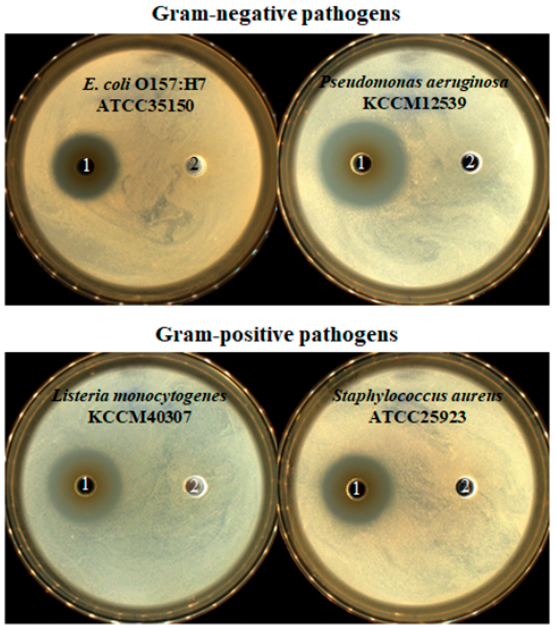
Figure 5. Antibacterial activity of LPLB5. 1, culture supernatant of LPLB5; 2, MRS broth as control. Antibacterial activity of culture supernatant of LPLB5 against E. coli O157:H7, p. aeruginosa, Leu. monocytogenes, S. aureus using the agar well diffusion assay. Four pathogenic bacteria were spread on tryptic soy agar (TSA) plates, then 120 µ L of culture supernatant was added to the wells, previously punched into the agar. The plates were incubated at 37 ◦ C for 24